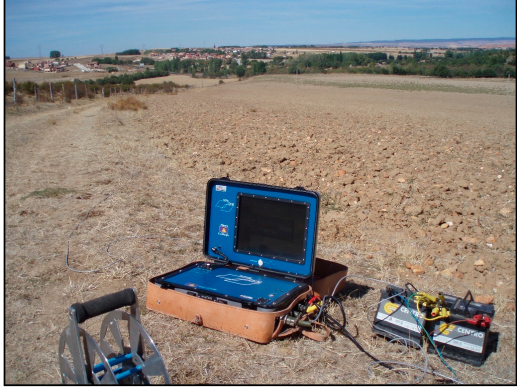
Figure 4. TDEM equipment in the area under study.